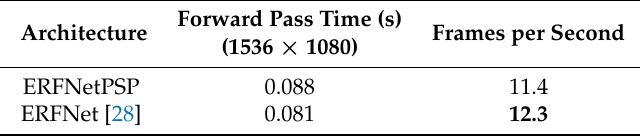
Table 5. Forwarding time and frame-rate for the presented